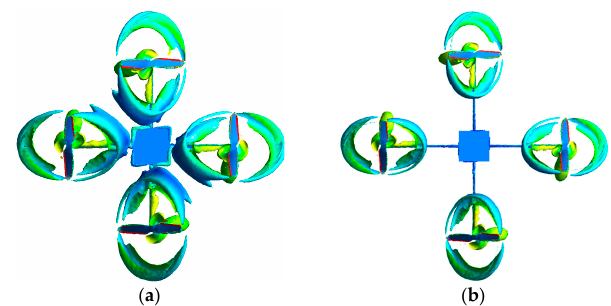
Figure 11. Vorticity distribution of 816s − 2 defined by the Q criterion: ( a ) 50-1.2 ( b ) 50-1.6.